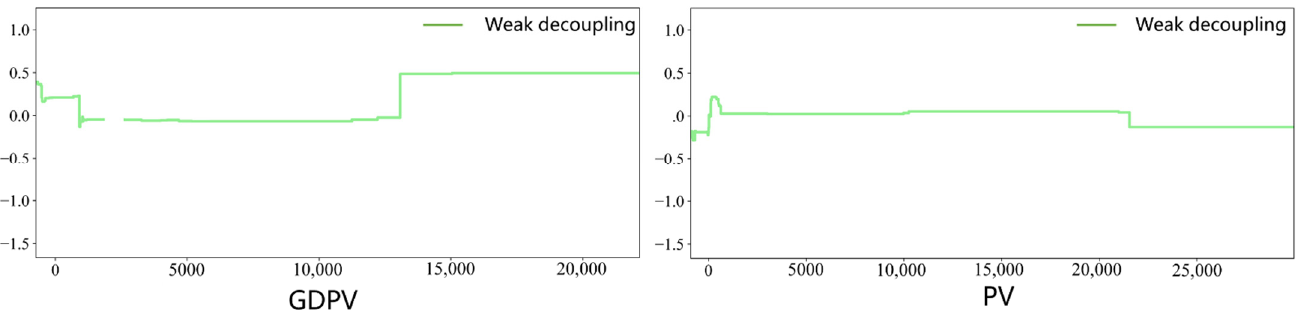
Figure 10. The antagonism relationship of WED in the economic development. Table 5. Results of variable relative importance on the formation of